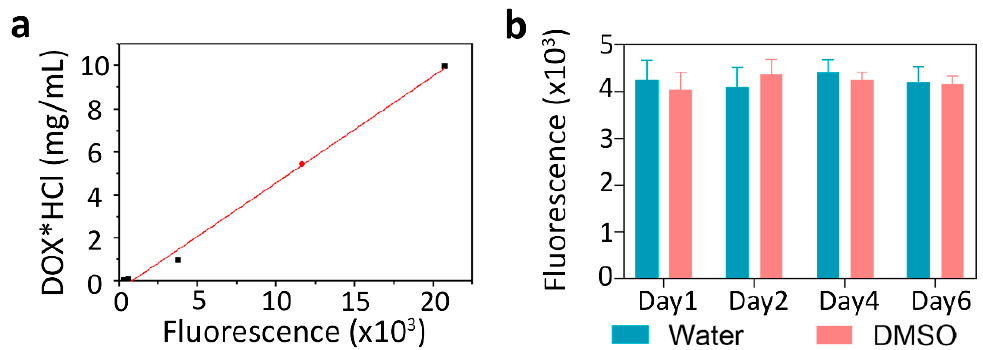
Figure 6. Characterization of PLGA nanoparticles. ( a ) Calibration curve for the measurement of doxorubicin*HCl incorporation into PLGA nanoparticles obtained with fluorescence spectroscopy (excitation 480 nm, emission 590 nm). The red dot indicates the measured doxorubicin concentration in a 1 g/L sample of PLGA particles. ( b ) The stability of fluorescence of PLGA particles loaded with doxorubicin and Nile Blue both in water and in the organic solvent, DMSO for 6 days.